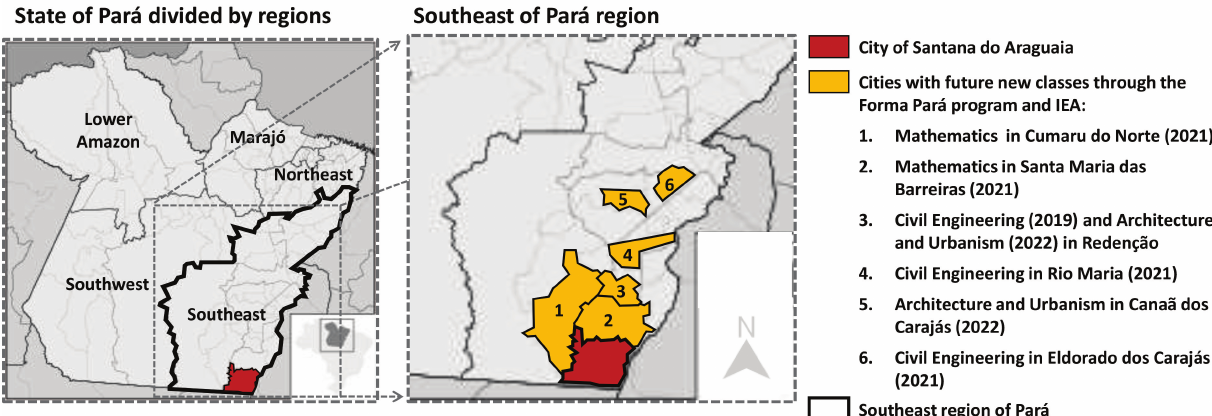
Figure 6. Individual classes in other cities offered by IEA/Unifesspa.